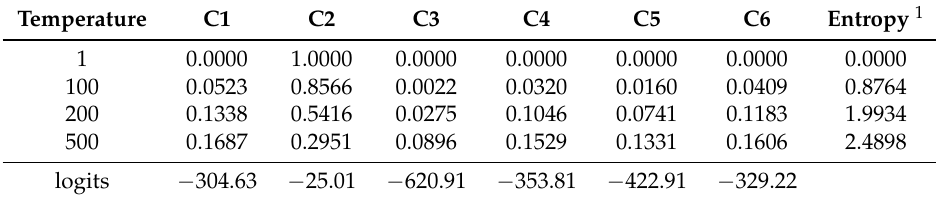
Table 1. An example of high-temperature softmax output with different